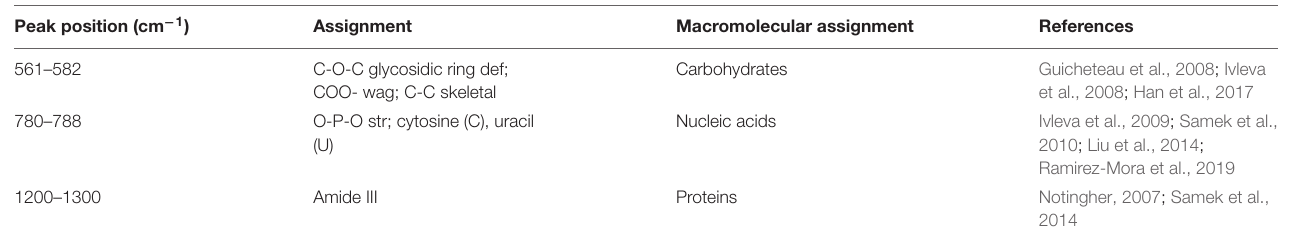
FIGURE 7 | Raman spectrum and intensity changes of mature biofilms of V. parahaemolyticus after treatment with DNase I, proteinase K, and their combination. (A) Raman spectrum and (B) intensity changes. Error bars show standard deviations of three independent experiments with five measurements each, and different letters represent significant differences among treatments ( P < 0.05). TABLE 4 | Peak assignment for Raman spectra of EPS in